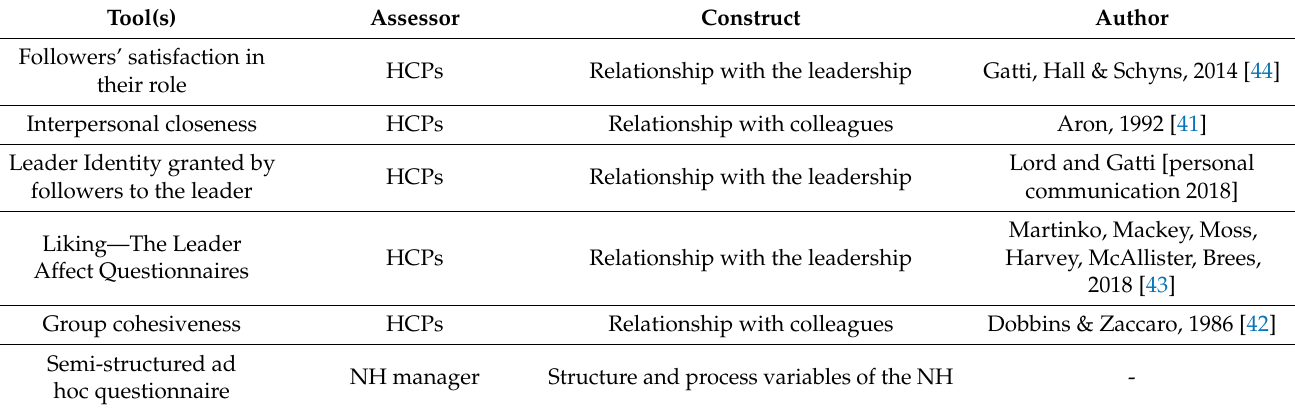
Table 1. Variables aimed at describing the context of the facility (in alphabetical